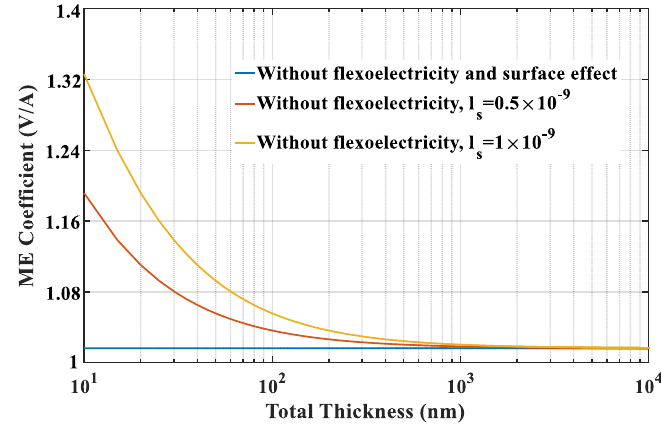
Figure 4. The effect of flexoelectricity of FE phase on the ME coefficient.